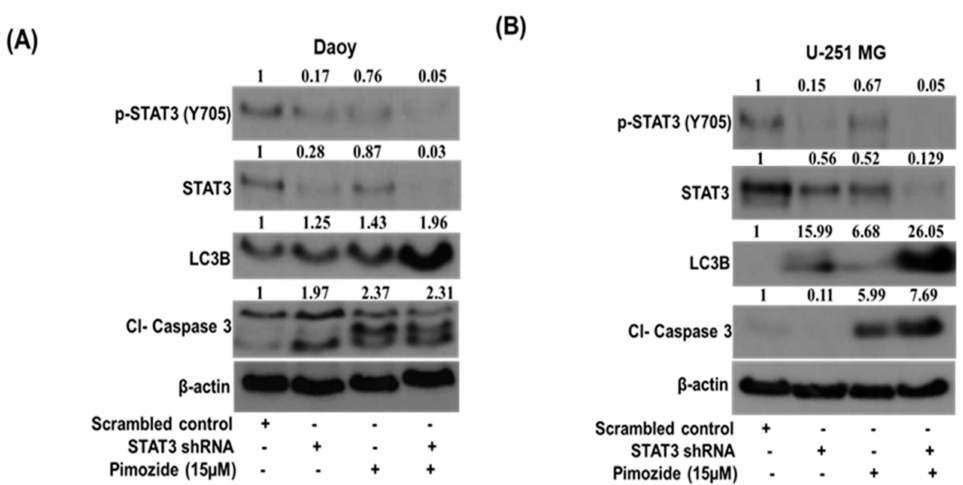
Figure 8. Pimozide suppresses the growth of brain tumor cells by inducing STAT3-mediated autophagy. ( A , B ) Approximately 0.2 million Daoy and U-251 MG cells were transfected with 5 µ g of STAT3 shRNA followed with the treatment of 15 µ M pimozide for 48 h. STAT3 inhibition, the induction of autophagy marker LC3B, and the level of apoptosis induction were evaluated by Western blotting analysis. β -actin was used as a loading control. The figure is a representation of at least three independent